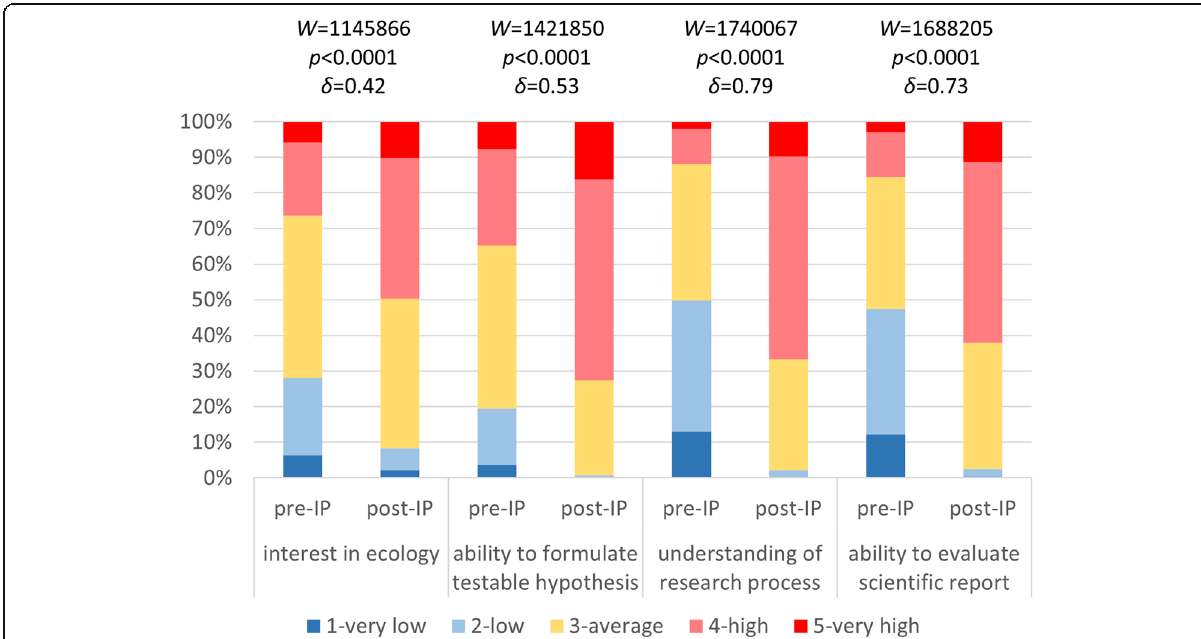
Fig. 2 Students ’ self-perception of learning. Distributions of self-reported levels of interest in ecology, ability to formulate testable hypotheses, understanding how ecologists conduct research, and ability to evaluate quality of scientific report, before (pre-IP) and after (post-IP) the inquiry project ( n = 2714). The W statistic and p value for Wilcoxon signed-rank test and the effect size (Cliff ’ s delta, δ ) are shown above each category